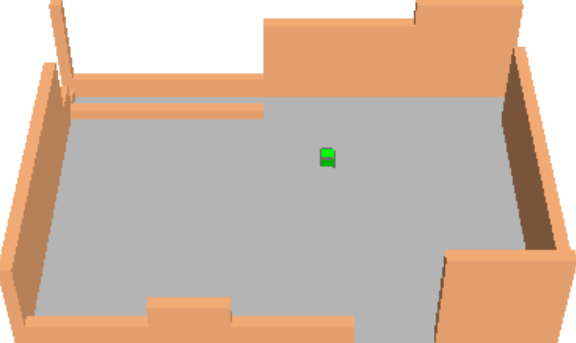
Figure 11. Current layout (S1).